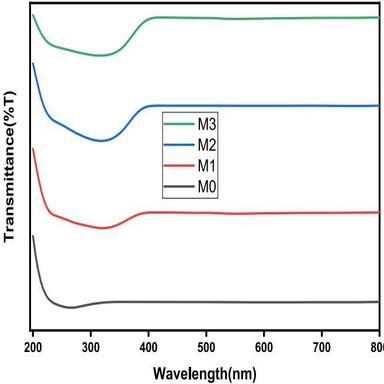
Light transmission curve of composites from wavelength 200 nm–800 nm.